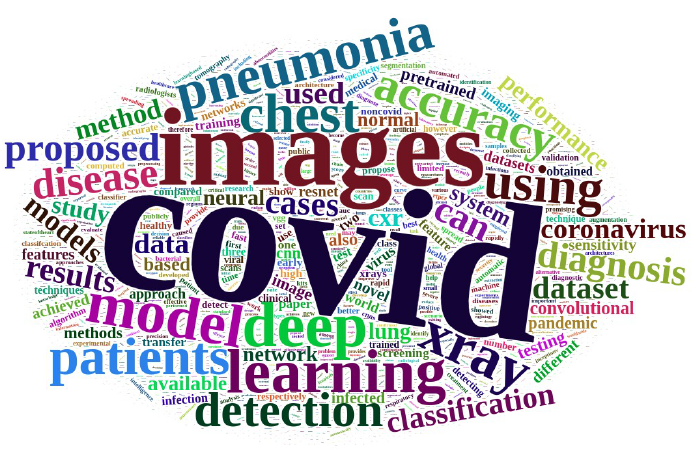
Figure 5. Wordcloud of all